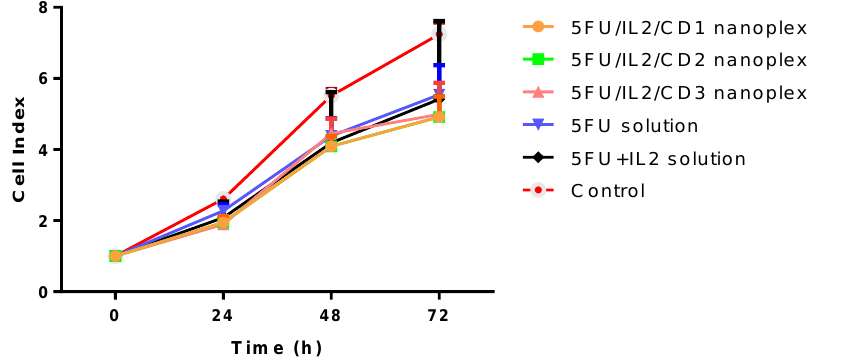
Figure 1. Cell index values of CT26 cells applied with 5FU/IL2/CD nanoplexes, 5-FU solution, 5-FU+IL-2 solution, and control, assessed by xCELLigence RTCA. The control group was treated with DMEM and was considered as 100% (n = 4, ± SD).